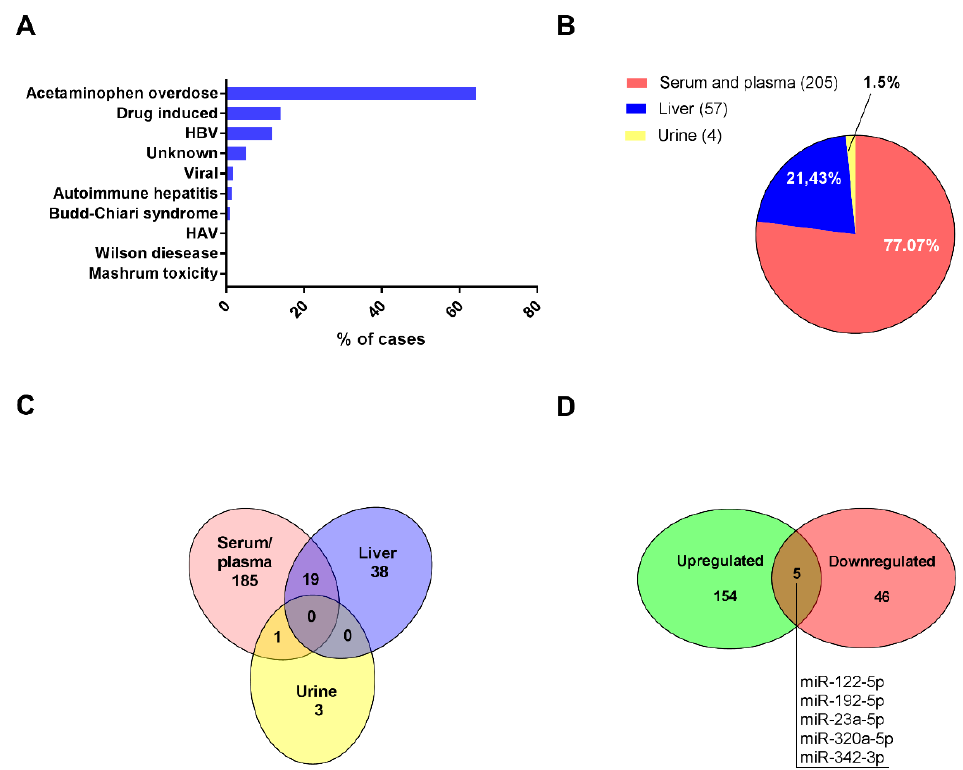
Figure 2. Characteristics of the last decade’s studies on differential miRNAs in ALF. Etiology of ALF (panel ( A )). Pie chart presenting the number of differently expressed miRNAs in the referred specimens (panel ( B )). Venn diagram showing overlapping of differently expressed miRNAs (panel ( C )). The number of up and down-regulated miRNAs in serum and plasma samples. Overlapped miRNAs were regulated both up and down as was based on selected publications (panel ( D )).